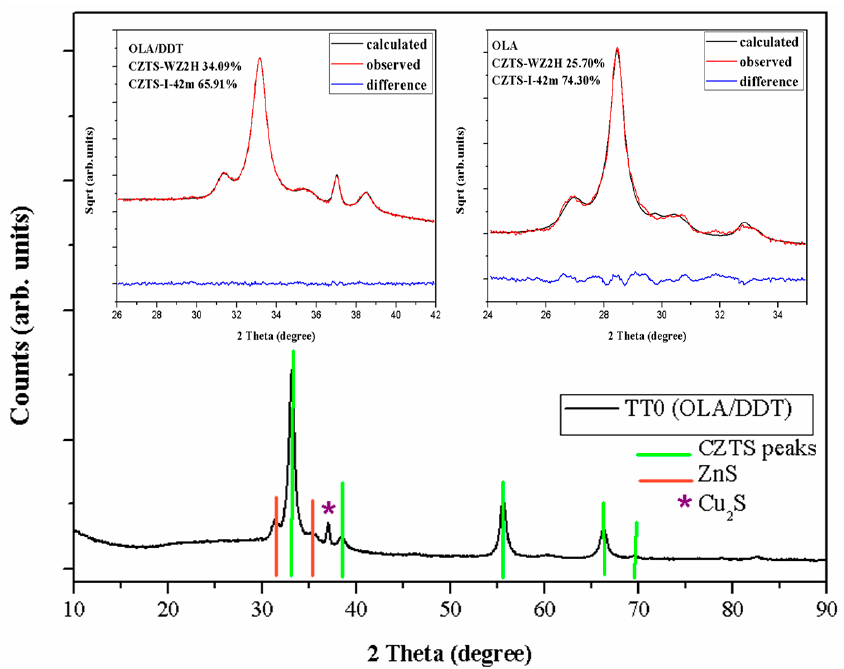
Figure 1. XRD pattern of CZTS samples after soft thermal annealing (TT0), the inset is XRD pattern of samples oleylamine / 1-Dodecanethiol (OLA / DDT) (data collected with CoK α radiation) and OLA (data collected with CuK α radiation) at TT0 analyzed by Topas.